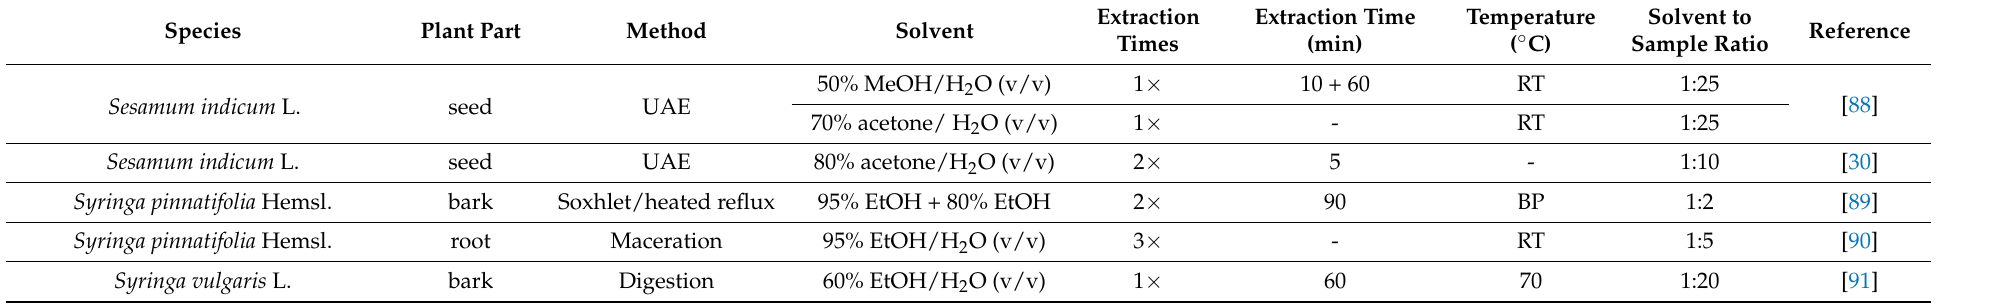
Species Plant Part Method Solvent